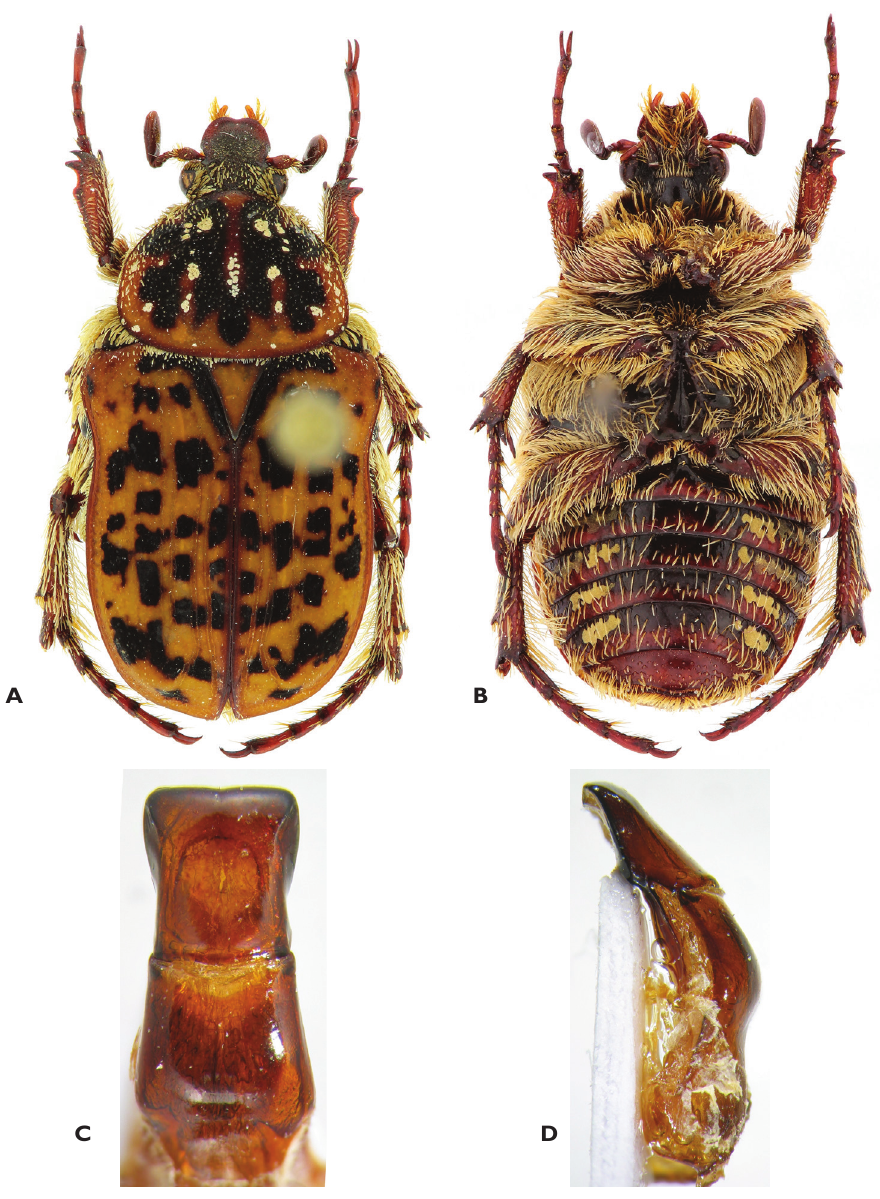
Figure 3. Atrichelaphinis ( Atrichelaphinis ) tigrina (Olivier, 1789), male, South Africa, Western Cape (PCSR). A Dorsal view B ventral view C parameres in dorsal view D parameres in lateral